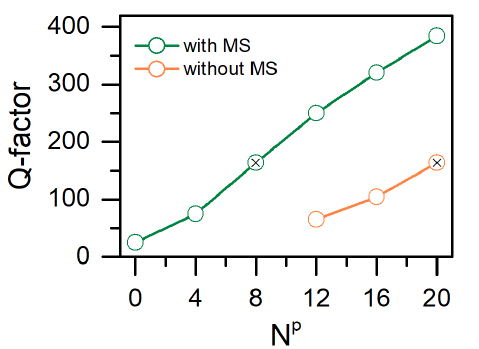
Figure 3. The dependence of the Q -factor of the chiral optical Tamm state on the number of PPAM periods, N p , with and without the metasurface. The leftmost green open circle corresponds to the previous experimental result [28]. Black crosses have comparable Q -factors and correspond to Figure